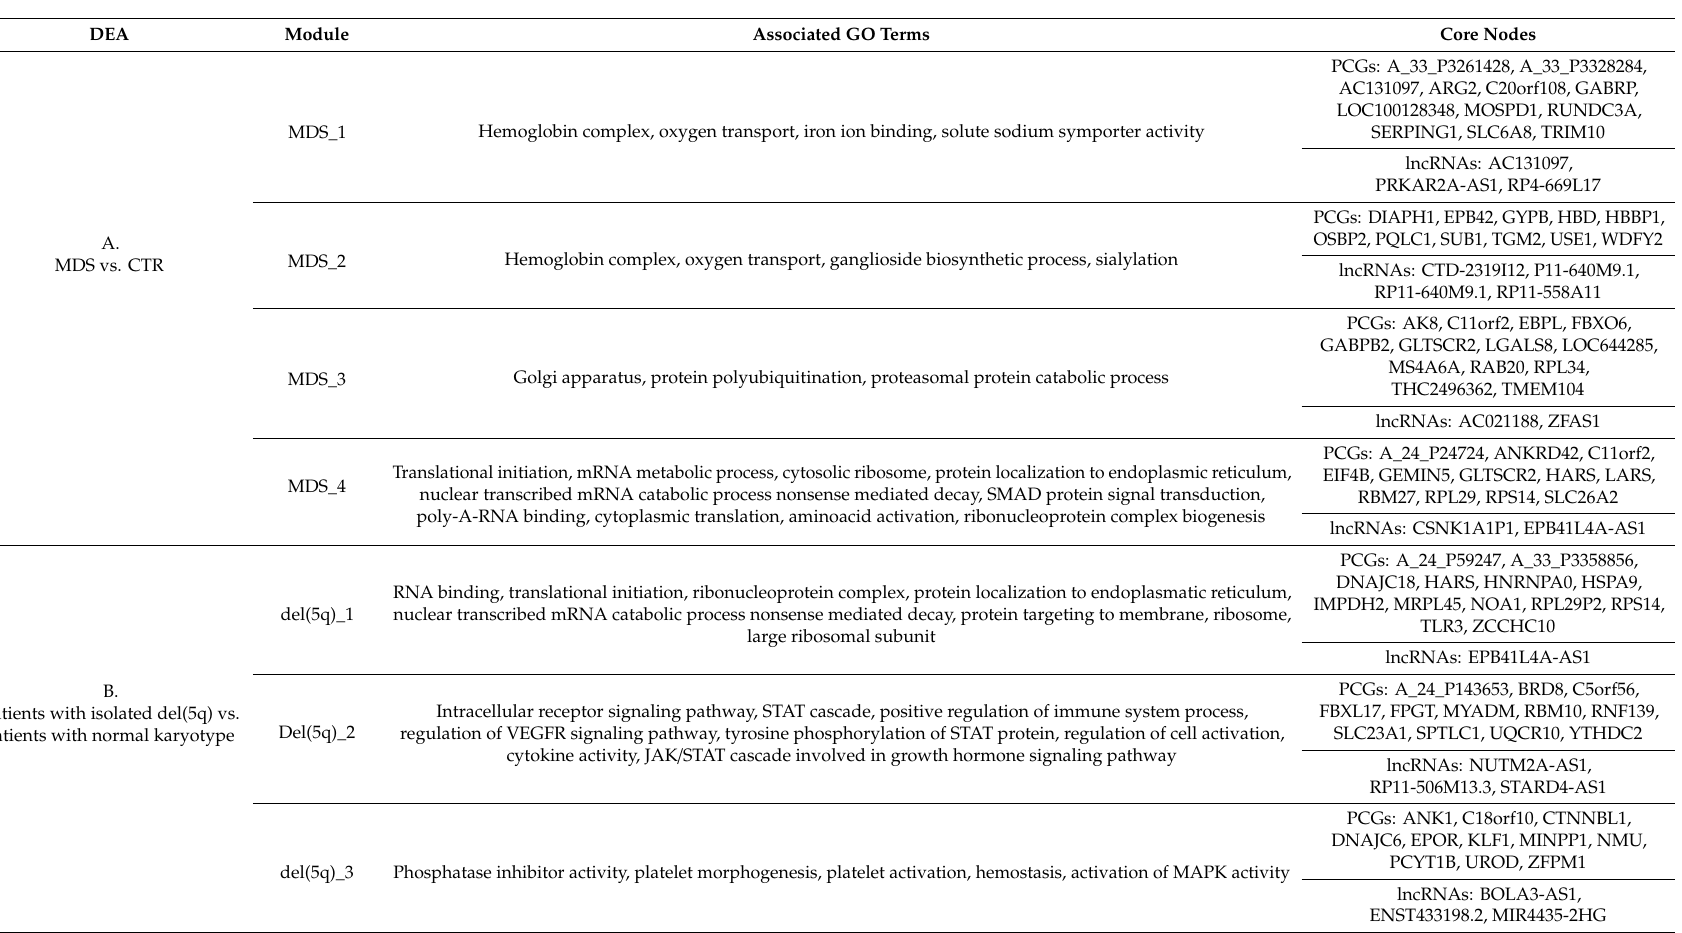
Table 1. Characteristics of selected modules in lncRNA-PCG coexpression networks based on di ff erentially expressed genes between ( A ) MDS patients and healthy controls, ( B ) patients with isolated del(5q) and patients with normal karyotype, ( C ) RUNX1-mutated and RUNX1-wild type patients, and ( D ) MDS patients with lower- and higher-risk IPSS-R. Enrichment analysis was done to associate module PCGs with GO terms ( p < 0.01). The representative core PCGs and lncRNAs with the highest module membership are